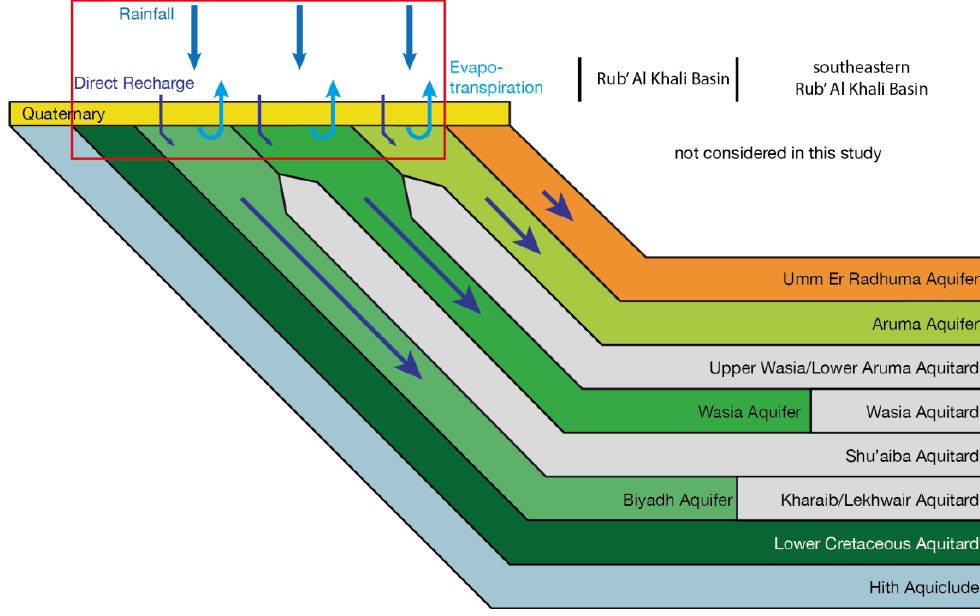
Figure 3. Conceptual aquifer model (not to scale) of the Al Kharj area (red box) with strata discussed in the text. Surface runoff is not shown in this figure.